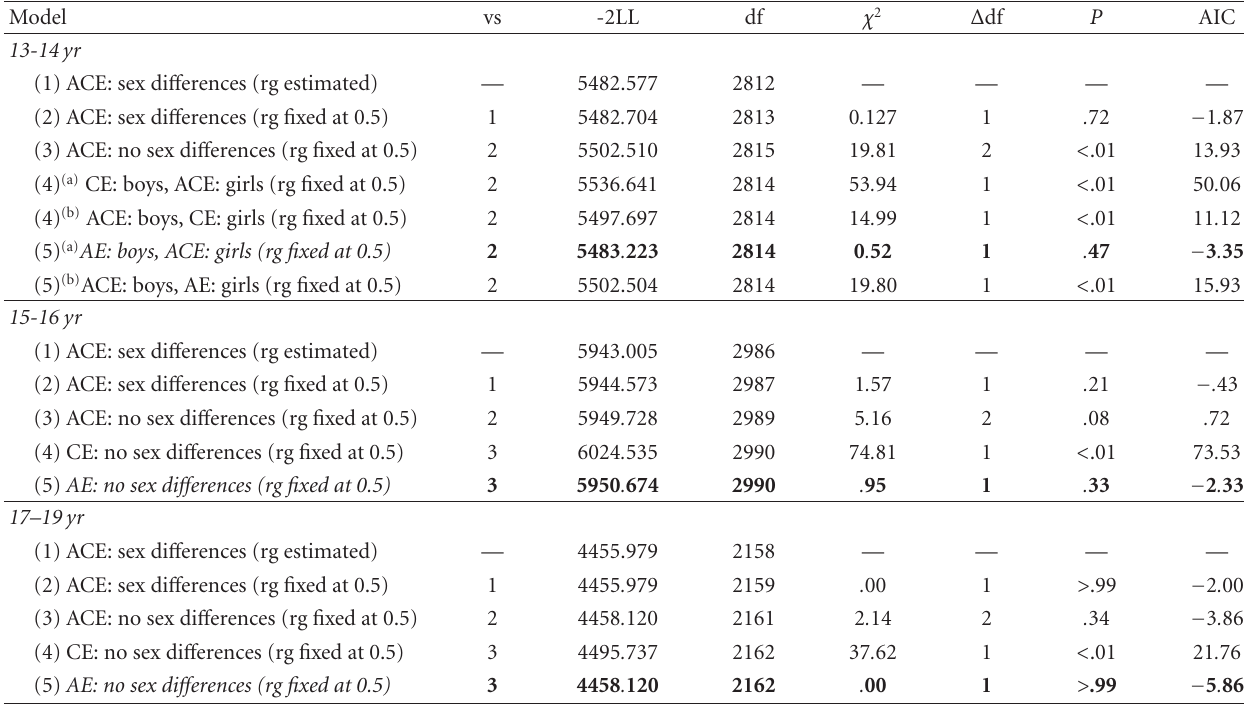
Table 4: Univariate model fitting results for exercise behavior in the three-age groups. Model vs -2LL